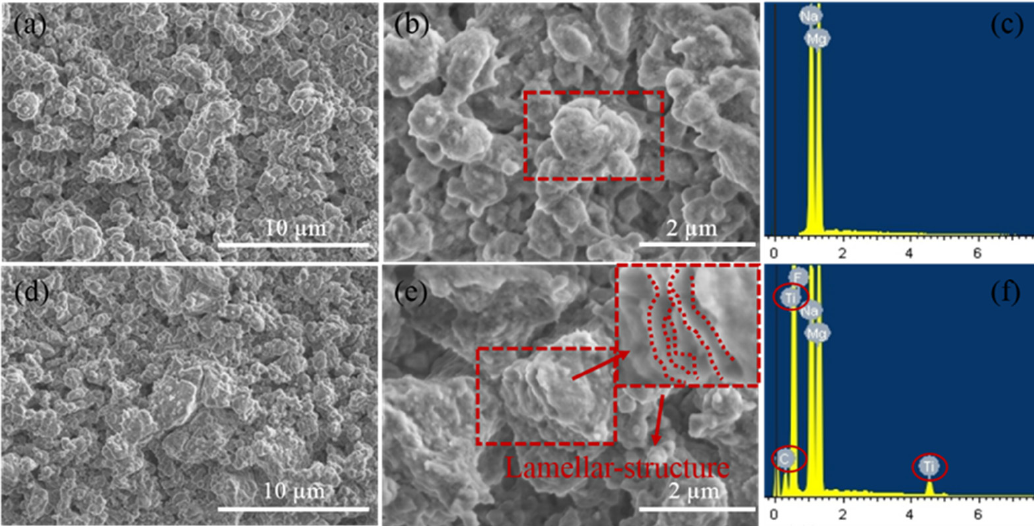
Figure 5. SEM images of ( a , b ) NaMgH 3 and ( d , e ) NaMgH 3 -7 wt.% Ti 3 C 2 ; EDS results of ( c ) NaMgH 3 and ( f ) NaMgH 3 -7 wt.% Ti 3 C 2 . wt.% Ti 3 C 2